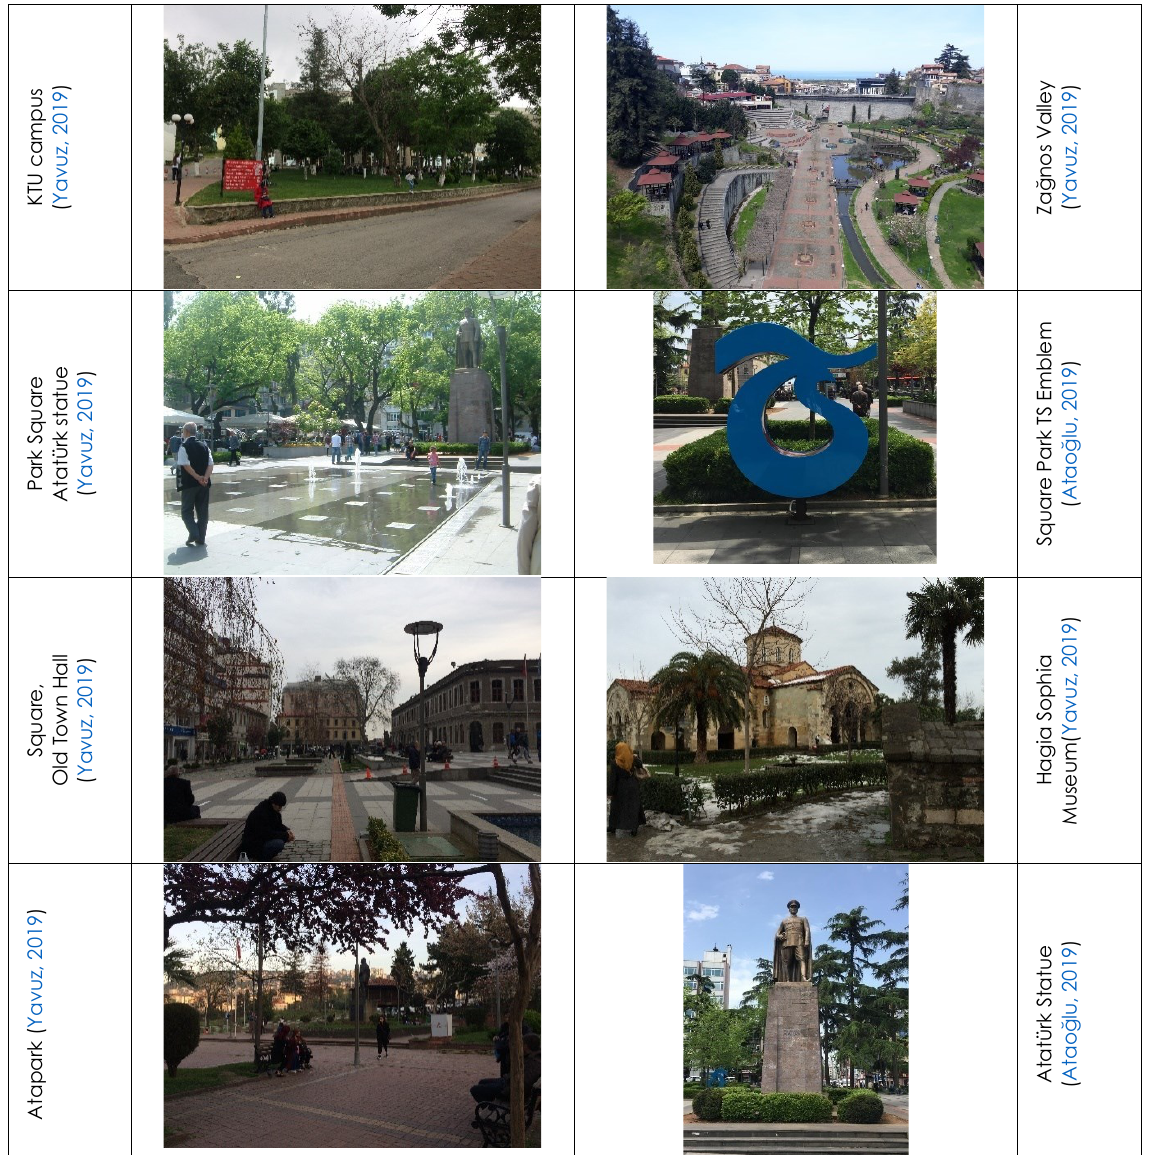
Figure 4 . Images of the study field ( Ataoğlu, 2019 ; Yavuz,